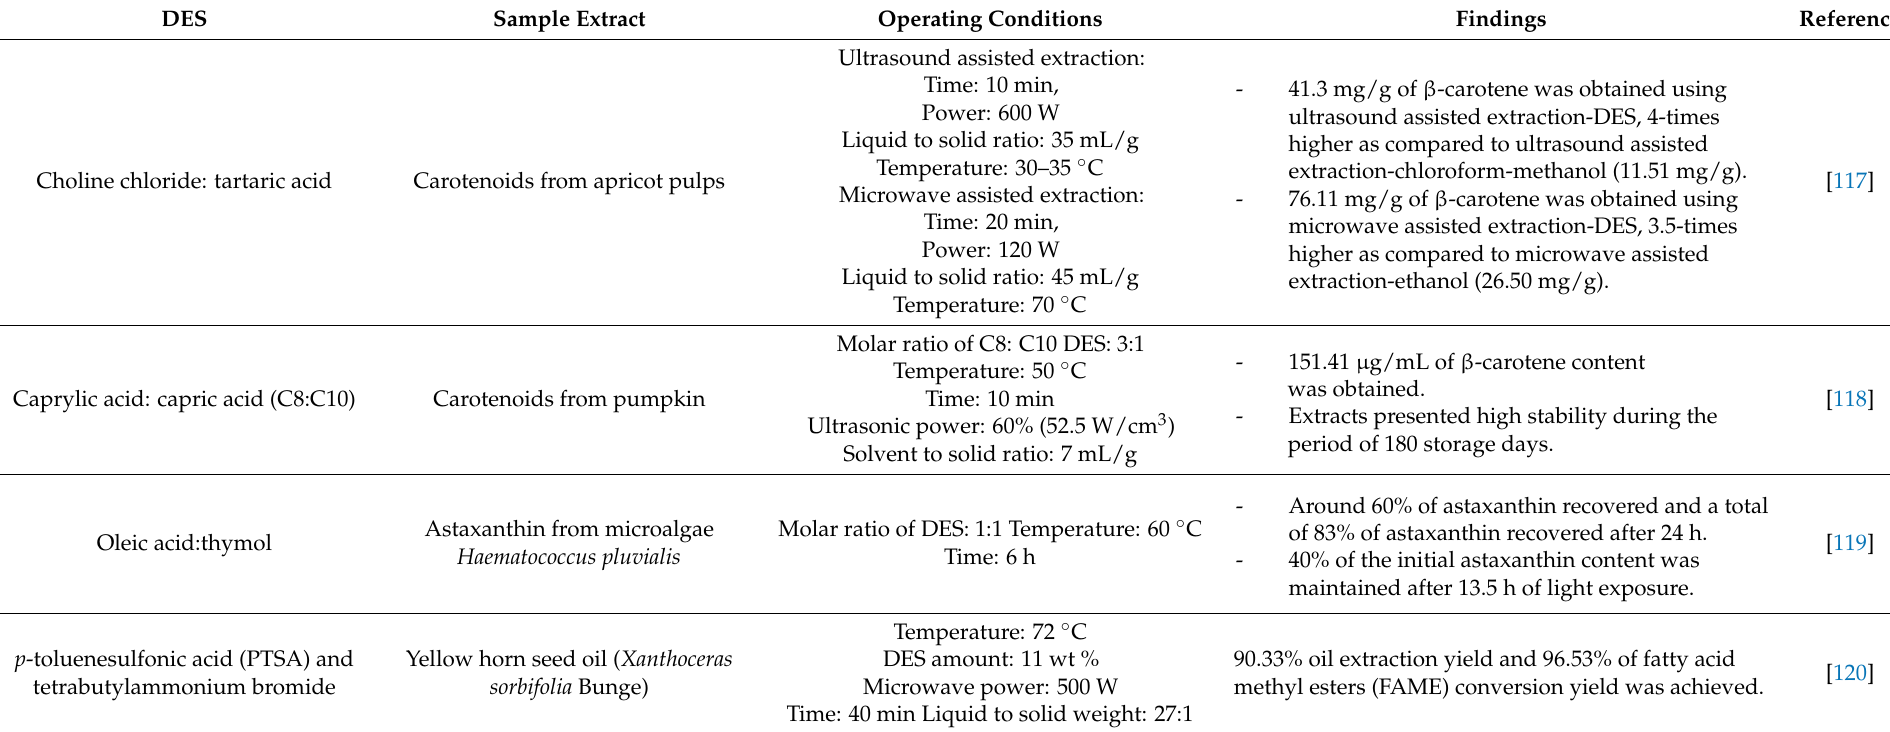
Table 4. Summary of the application of DES in extraction of